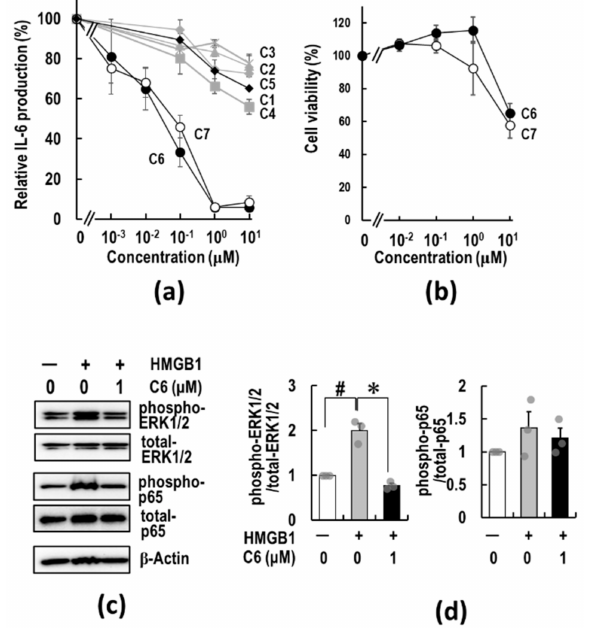
Figure 2. Anti-inflammatory activities of synthesized 3-styrylchromone derivatives. ( a ) Suppressive effects of 3-styrylchromone derivatives on IL-6 production in RAW264.7 cells. RAW264.7 cells were pre-treated with 3-styrylchromone derivatives for 2 h, followed by stimulation with 5 µ g/mL HMGB1. After 18 h incubation, IL-6 released in the medium was measured by ELISA as described in Section 4. The data are presented as mean ± SE of four independent experiments. The symbols of the compounds are listed below; C1 (closed diamond), C2 (gray closed triangle), C3 (gray cross), C4 (gray closed square), C5 (gray closed diamond), C6 (closed circle), and C7 (open circle). ( b ) Cell viability of C6 and C7 was determined by the WST-8 assay as described in Section 4. Data are shown as mean ± SE of three independent experiments. (c and d) RAW264.7 cells were pre-treated with or without 1 µ M C6 for 2 h and then stimulated by 5 µ g/mL HMGB1. After 15 min incubation, the phosphorylation of ERK1/2 and NF- κ B (p65) was measured via Western blotting as described in Section 4. β -Actin served as a loading control. The panels depicting typical immunoblots ( c ) and the relative ratio of each band intensity of ERK1/2 (left) and p65 (NF- κ B) (right) were determined by densitometric analysis ( d ). Data are expressed as mean ± SE of three independent experiments. The significance was tested by the Student’s t -test (# or * p < 0.05 for non-treated group vs. HMGB1 or HMGB1-treated group vs. C6 -treated group, respectively). The original image of Figure 2c is shown in Supplementary Figure